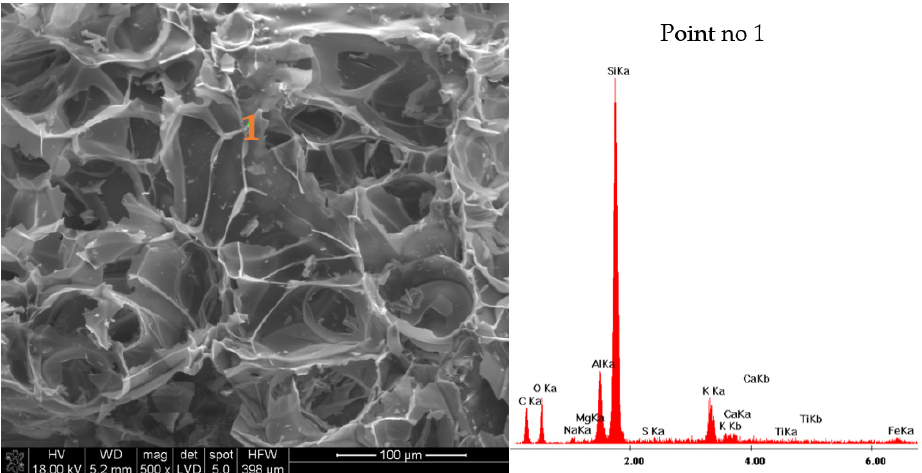
Figure 3. Microstructure of expanded perlite grain in 500 times magnification with EDS analysis in point 1.